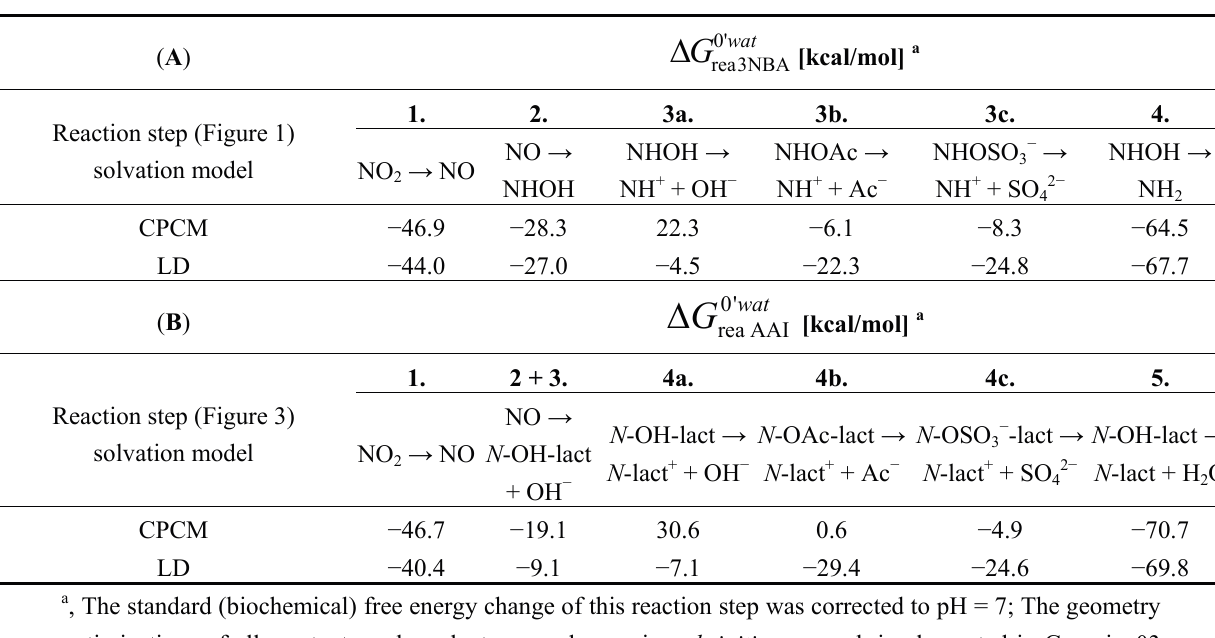
Table 3. Standard reaction free energies of individual reaction steps of 3-NBA ( A ) and AAI ( B ) conversion calculated by quantum chemical approach in combination with the polarizable conductor calculation model (CPCM) and the Langevin dipoles model (LD) (for methods, see